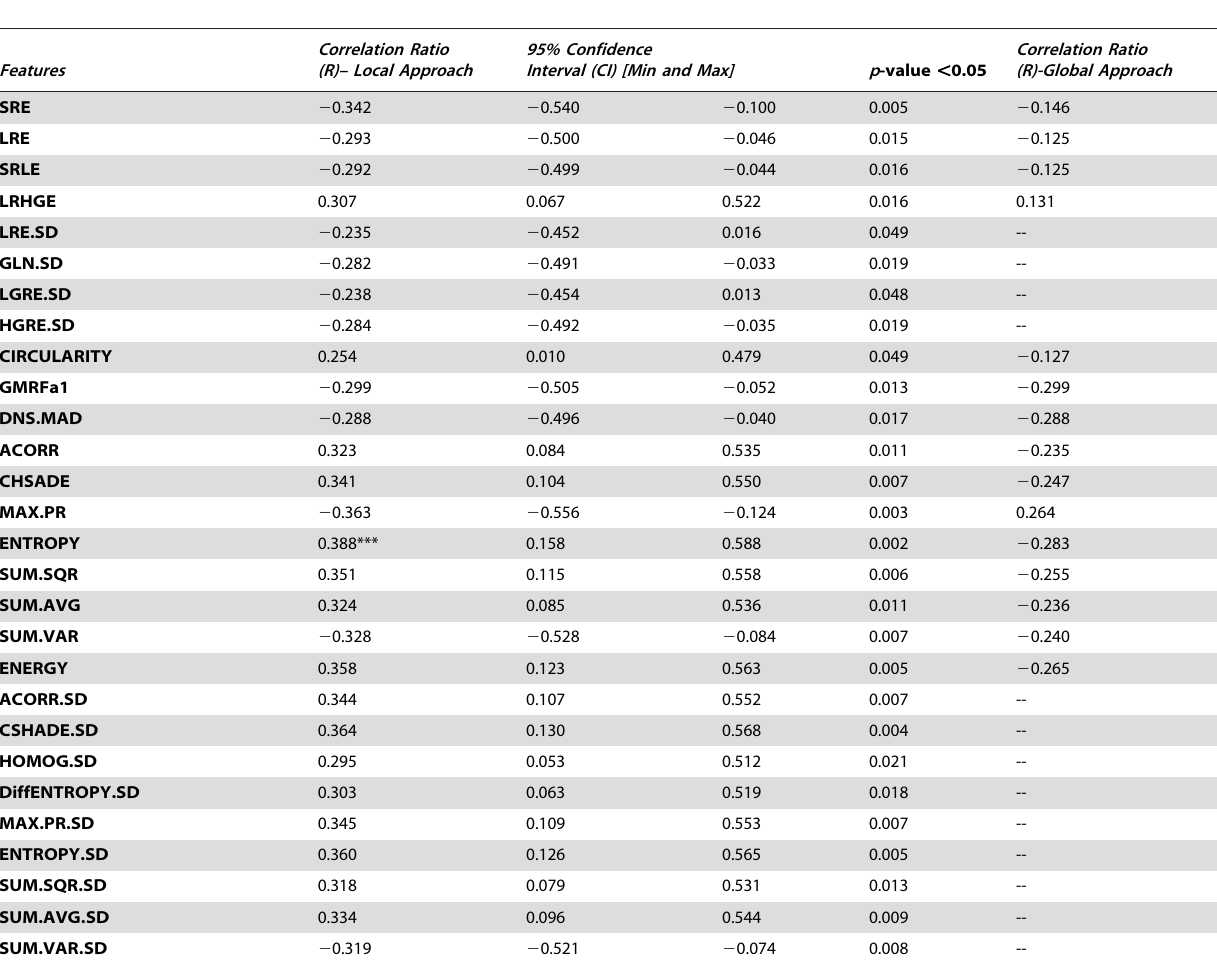
Table 3. Correlation ratios, 95% confidence intervals, and p-values of significantly correlating textural features with SUV max are